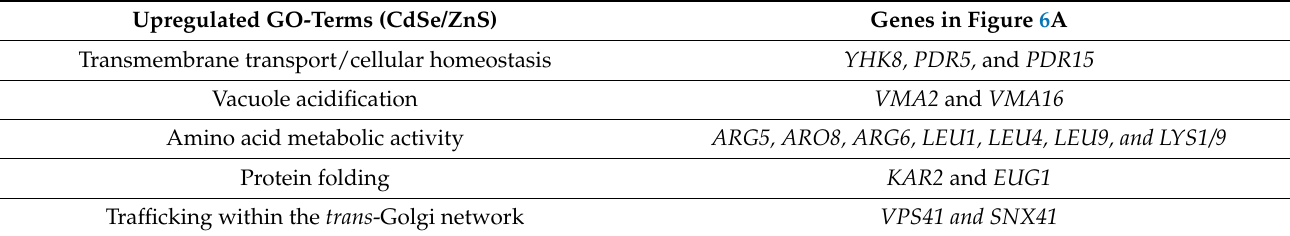
Table 3. A table listing the GO-terms and genes in Figure 6A. It represents the multiple upregulated cellular processes and genes in yeast exposed to 10 µ g/mL CdSe/ZnS QDs. All genes incorporated in this table exhibited expression levels significantly higher than expression levels of NTC